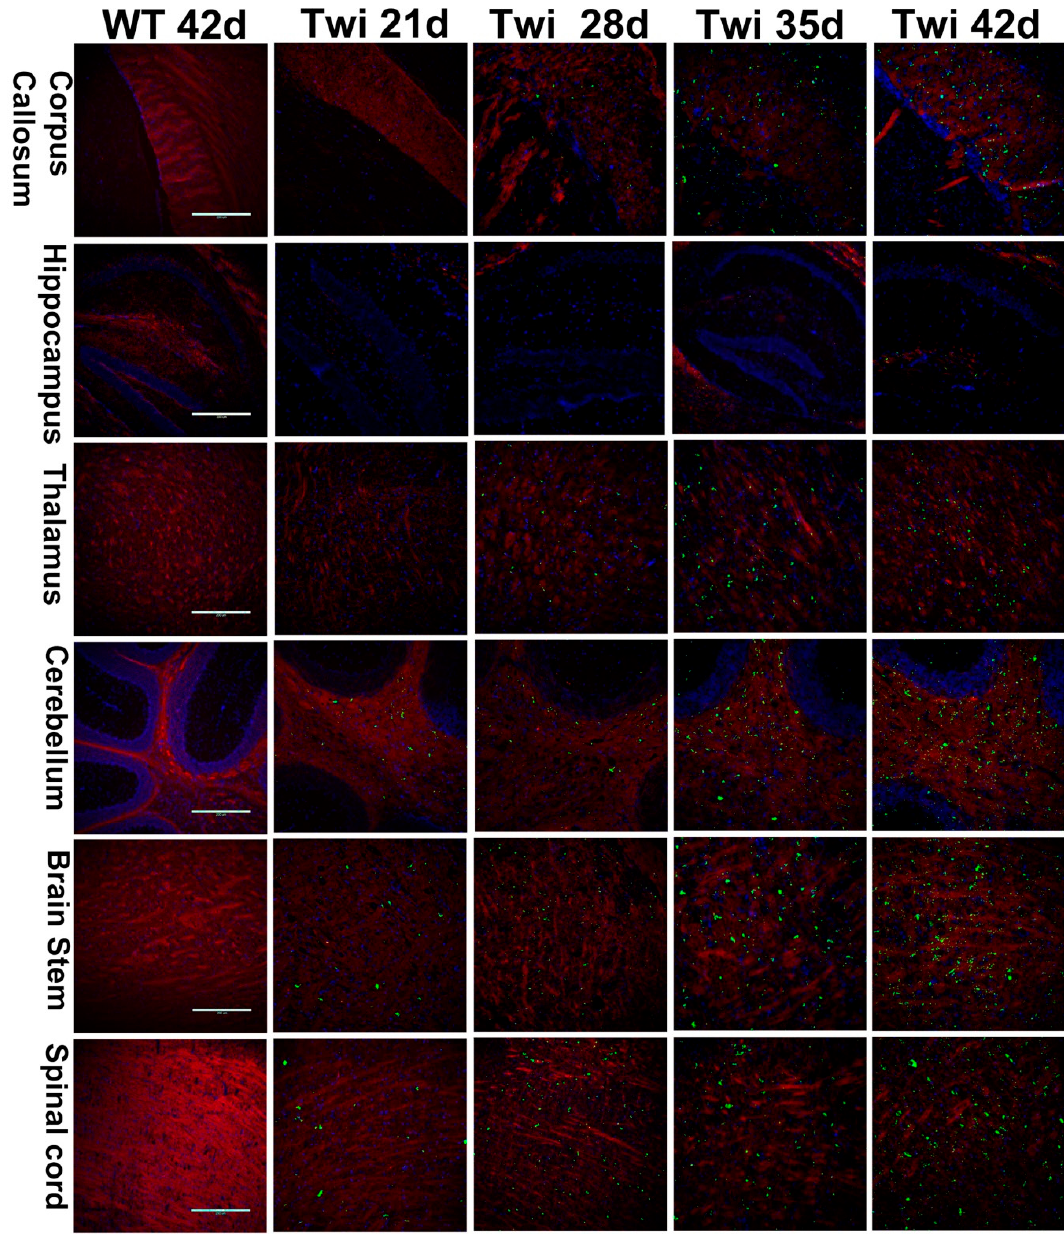
Figure 2. Progressive accumulation of p62 aggregates in the brain of twitcher mice. Distribution of p62 aggregates in different regions of the twitcher (Twi) brain at ages 21 to 42 days. The twitcher brain and wild-type (WT) brain were immuno-stained with anti-p62 (in green) and anti-PLP (in red), respectively, and nuclei were counterstained with DAPI (in blue). Scale bars: 200 μ m.